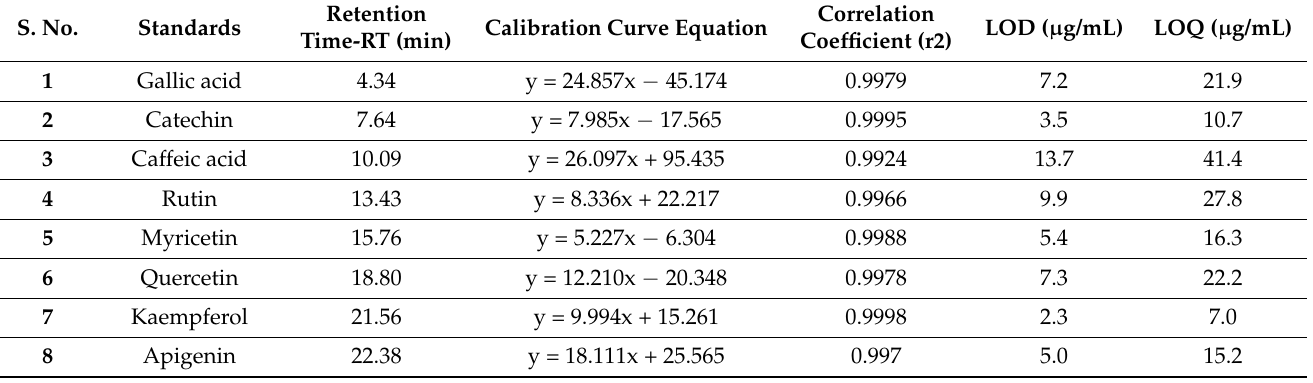
Table 1. Calibration curve equations, retention times, correlation coefficient, LOD, and LOQ values of all the standards.